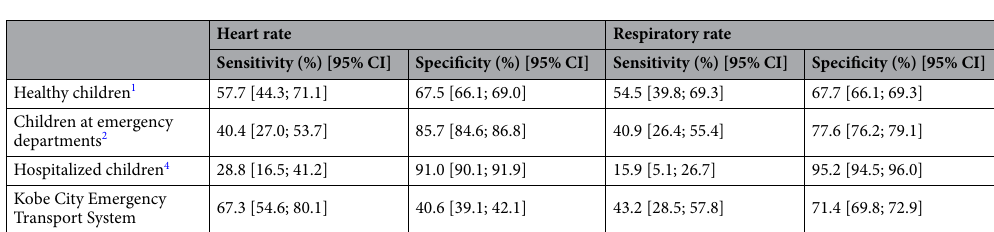
Table 1. The sensitivity and specificity for detecting patients with critical outcomes by using the 1st and 99th centiles of each reference range of the vital signs from the previously developed centiles, as well as the reference ranges of the Kobe City Emergency Transport System. CI, confidence